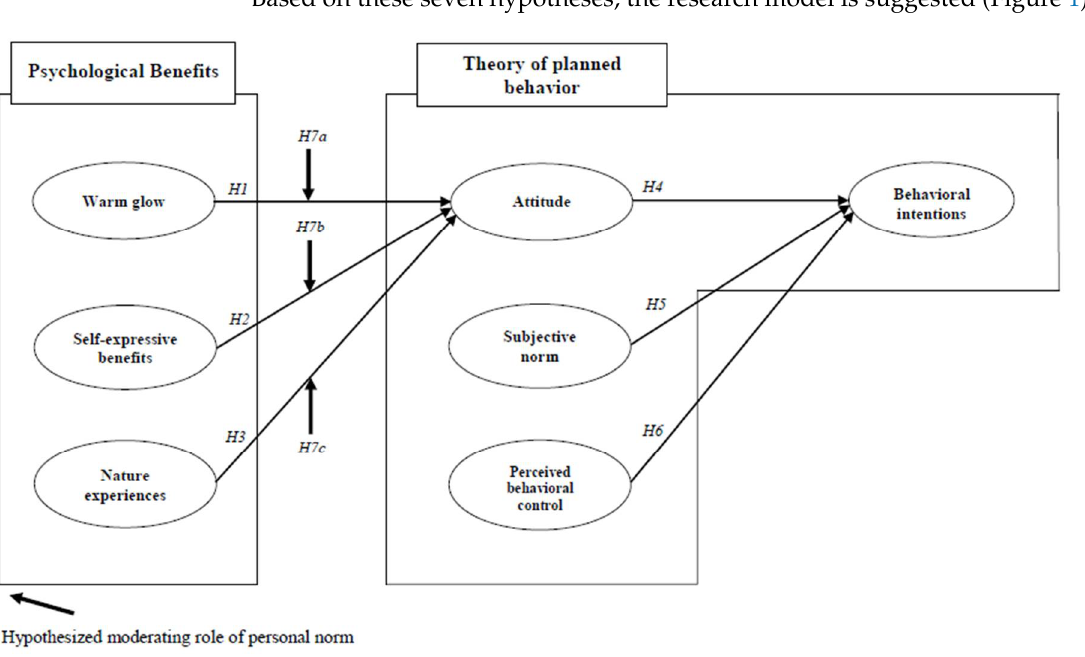
Figure 1. The proposed conceptual